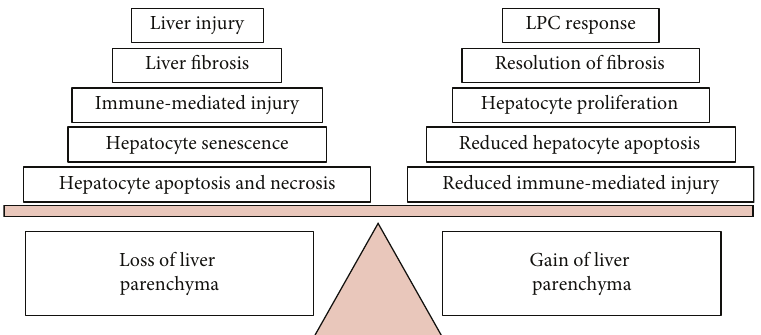
Figure 5: Mechanisms that contribute to the loss or gain of liver parenchyma during CLD. Liver repair following injury involves a balancing act between mechanisms that result in either loss or gain of the liver parenchyma. Accordingly, the progression of CLD can be framed as liver repair that favours parenchyma loss over gain. Flipping this balance in favour of parenchyma gain is the ultimate goal of regenerative therapies for